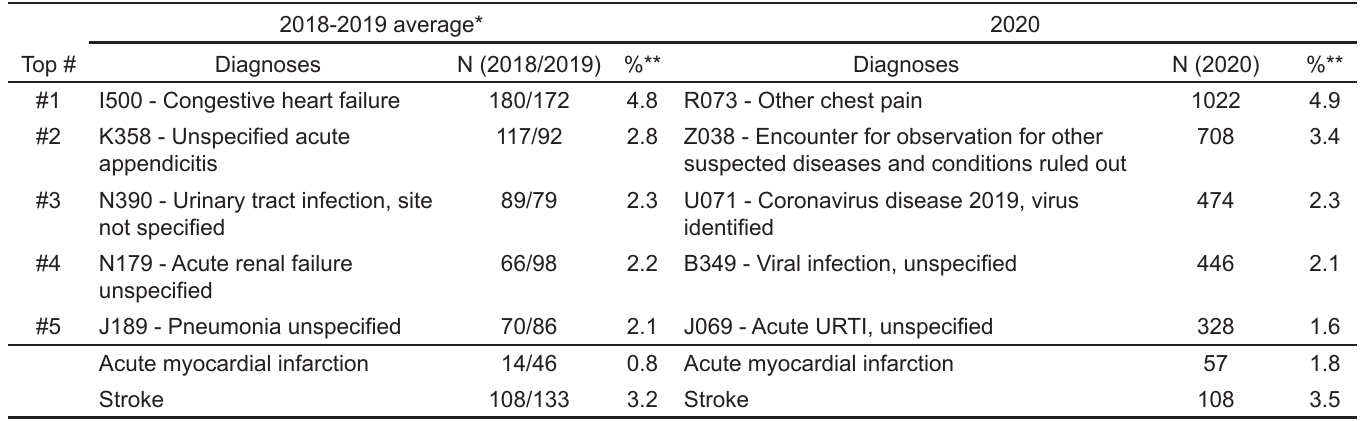
Table 5. Top admission diagnoses during study period (March 17–June 30) for the years 2018 to 2020.